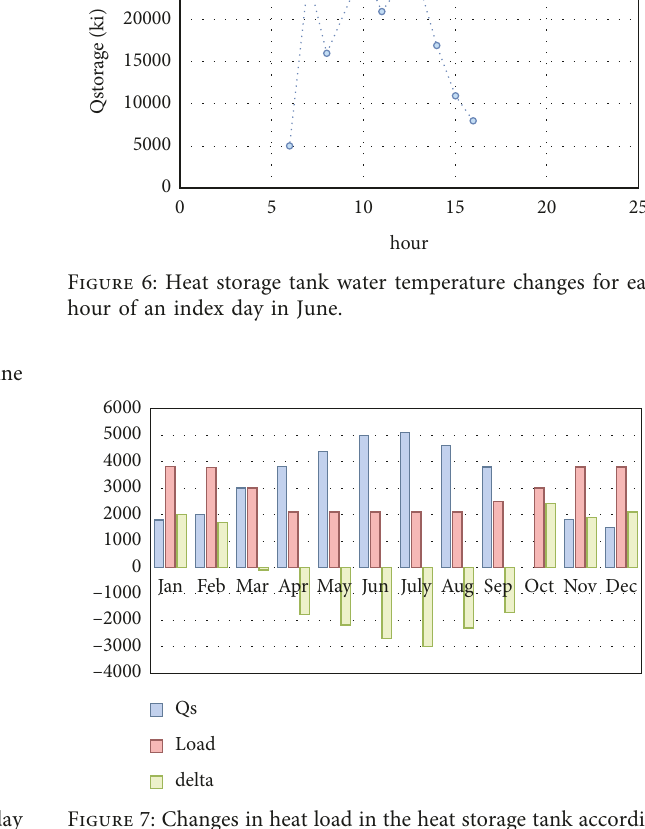
Figure 7: Changes in heat load in the heat storage tank according to the load consumed per month.